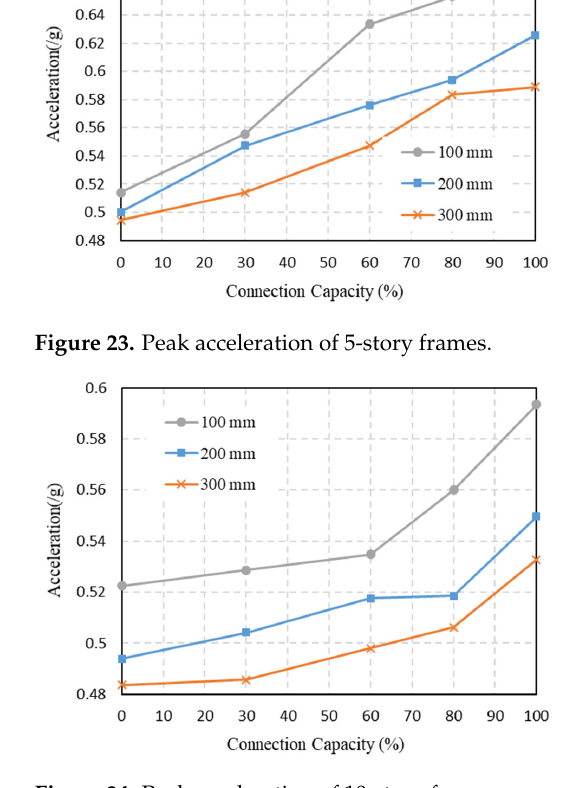
Figure 25. Peak acceleration of 15-story frames. As clarified previously, a combination of SPSWs and semi-rigid connections in the five-story frames resulted in drifts that were all below the limit required, which was 3%. This means that implementing moment-free connections with SPSWs that have 300 mm holes and 0% rigidity is not allowed. On the other hand, according to Figure 23, SPSWs that have 100 mm holes and rigid connections resulted in maximum acceleration. There- fore, frames that had SPSWs with 200 mm holes and moment frame connections resulted